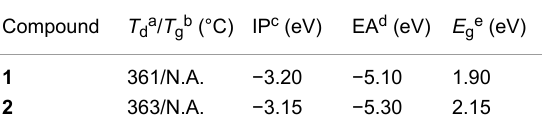
Table 1: Thermal and electrochemical properties of the investigated compounds 1 and 2 . Compound